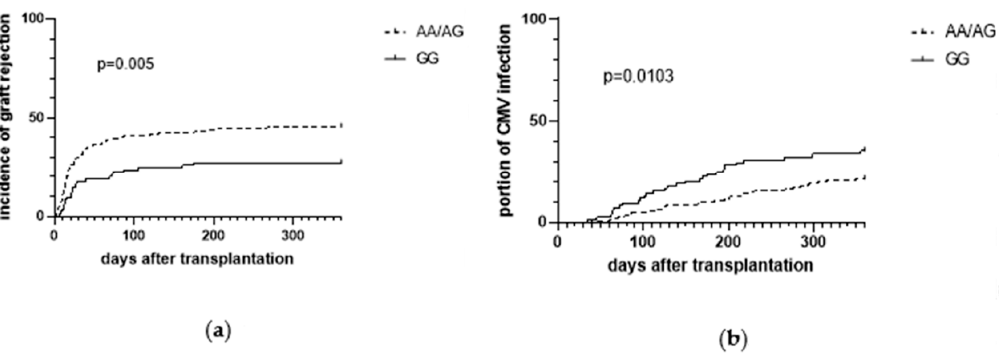
Figure 4. Kaplan–Meier curves showing the incidence of biopsy proven graft rejection ( a ) and the incidence of cytomegalovirus (CMV) infections ( b ) in the first year after kidney transplantation, stratified by the AA / AG and GG genotypes of the AQP3 A( − 1431)G single nucleotide polymorphism ( n = 237) as the percentual number of patients.